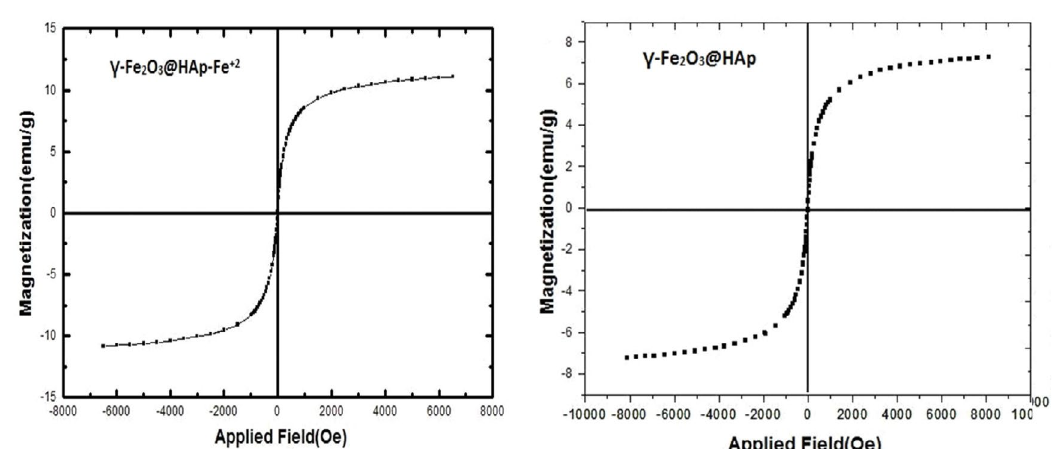
Fig. 4. VSM curves of γ-Fe